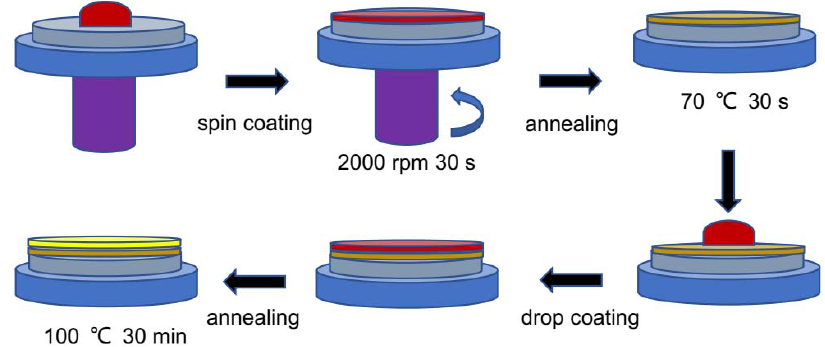
Figure 1. Schematic illustration of the perovskite thin films preparation progress.